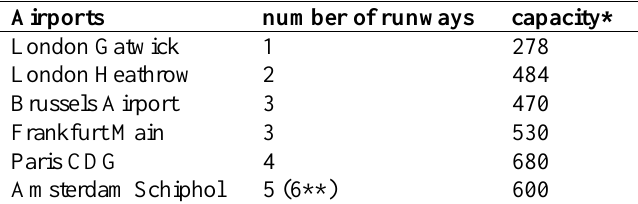
Table 2. Airport capacity (IFR movements/year x 1000) Airports number of runways capacity* 1 278 2 484 3